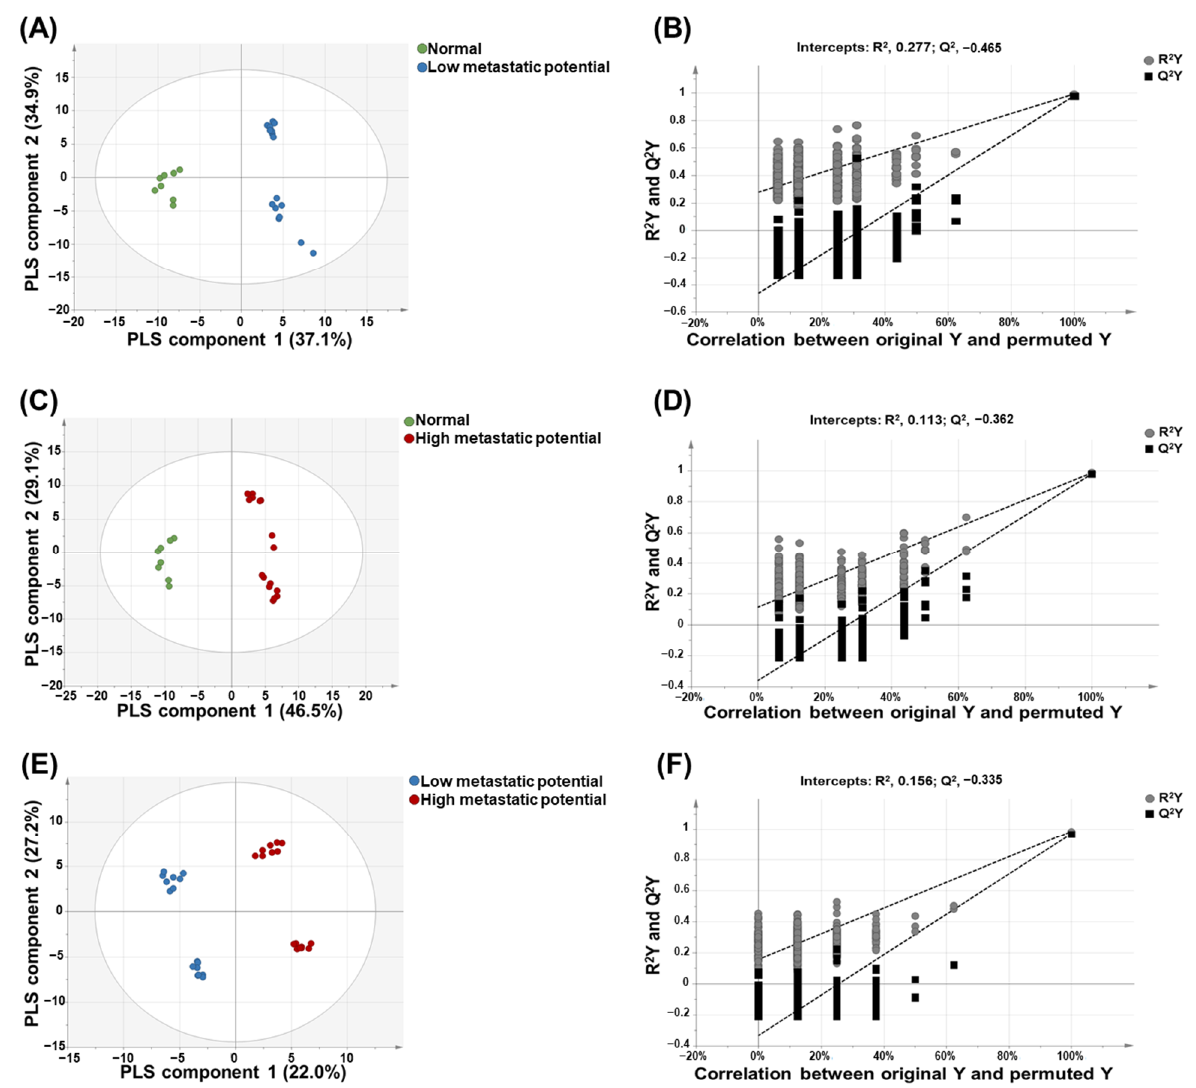
Figure 3. Partial least-squares discriminant analysis (PLS-DA)-derived score plots and permutation test. PLS-DA-derived score plot ( A ) and plots from permutation test ( B ) of normal versus low-metastatic potential cell lines; PLS-DA-derived score plot ( C ) and plots from permutation test ( D ) of normal versus high-metastatic potential cell lines; PLS-DA-derived score plot ( E ) and plots from permutation test ( F ) of low-metastatic potential versus high-metastatic potential cell lines. Based on the PLS-DA-derived loading plots and VIP values > 1.0, glyceric acid, glycerol, hydroxyproline, inosine, lactose, linoleic acid, phenylalanine, plasmenyl-phosphatidylethnolamine (PE) 16:0/18:1, phosphatidylinositol (PI) 18:1/20:4, phosphatidylserine (PS) 18:0/18:0, and putrescine were revealed as the major contributing predictive metabolites between the normal cell (HBEpC) and low-metastatic cell lines (H520 and HCC95) (Figure 4A).